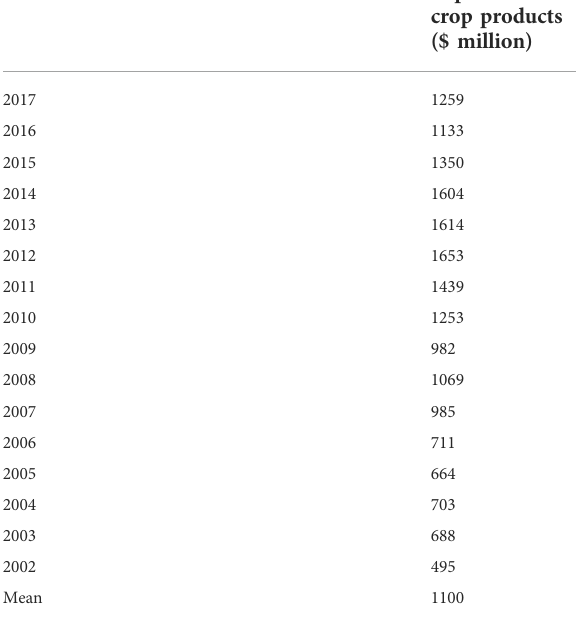
TABLE 8 Total export value of crop products in Louisiana (USDA Economic Research Service 2017).